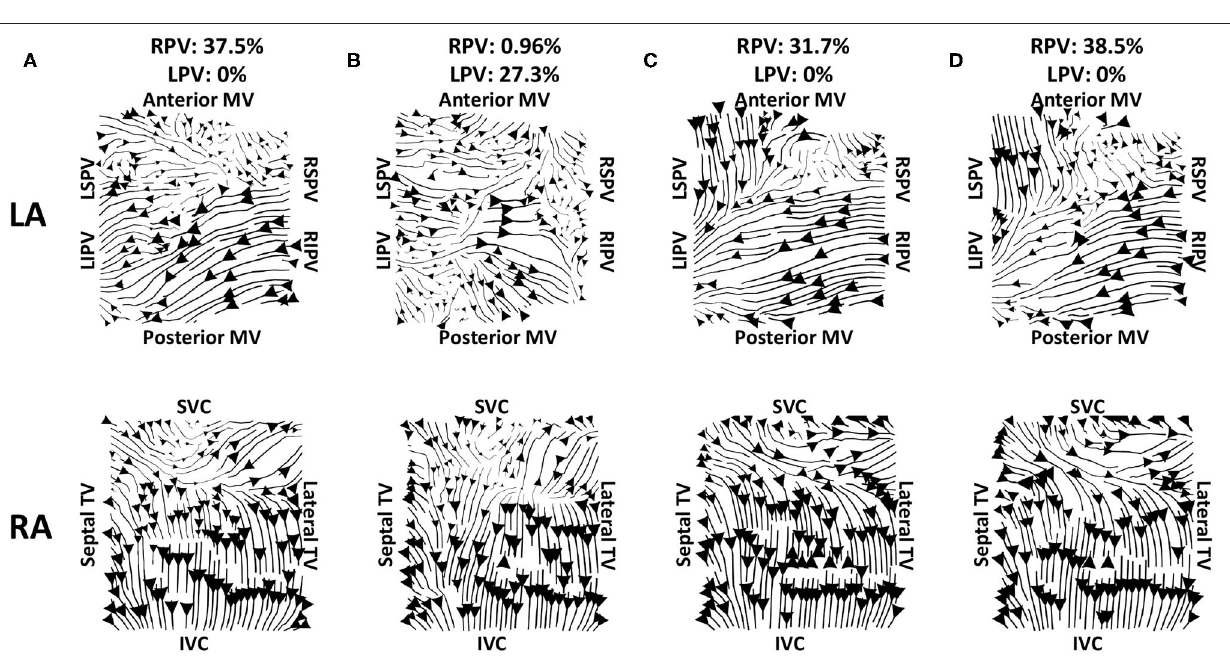
FIGURE 9 | Effects of recording duration on streamlines for example AF episode. Streamlines are shown for 10s recordings taken from intervals spread through the entire recording. The top row shows the left atrium, and the bottom row shows the right atrium. The streamline plots in (A) show the original interval; panels (C,D) are visually similar to (A) , while the LA for (B) demonstrates larger differences. The PV activation flow metrics from the right PV are as follows: (A) 37.5%, (B) 96%, (C) 31.7%, (D) 38.5%. There were 9 out of 10 recordings that had no activation flow from the left PV to the LA body, while (B) has a PV activation flow metric from the left PV of 27.3%. The start times for these recordings are 0, 6, 125, and